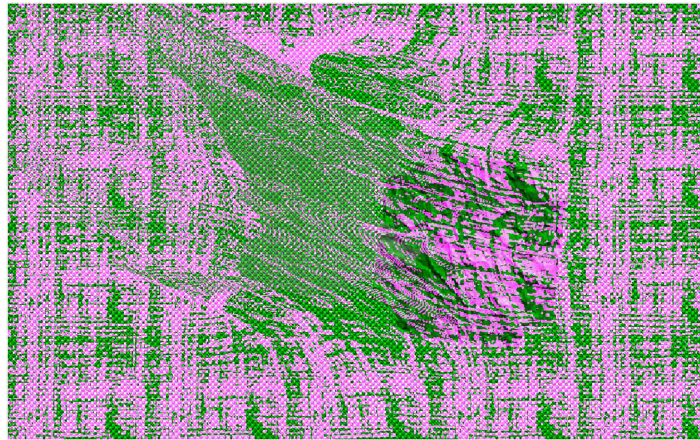
Figure 4. The synthetic image pair registered result by MIND.